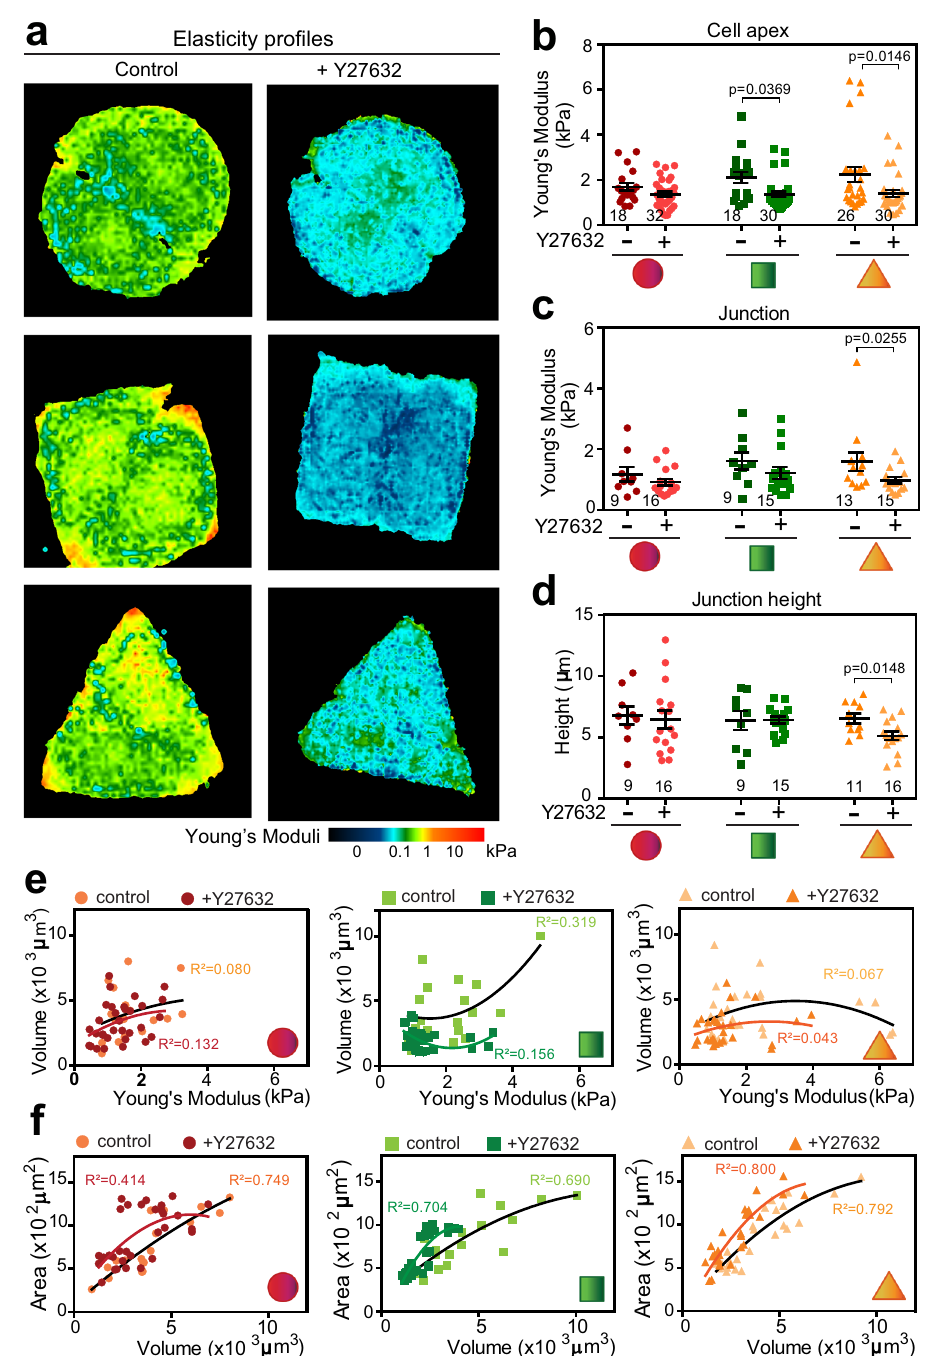
Fig. 7 | Inhibition of intracellular contraction interferes with rheological properties of highest tensile triangular cell pairs, but not those on circular con fi nement. Keratinocytes grown on different geometries were scanned using SICM in the presence or absence of Y27632. a Representative images of Young ’ s moduli maps are shown for each sample. Colour map follows the scale at the bottom of images from softer (dark blue) to stiffer values (red). b and c Young ’ s modulivaluesderivedfrom( a )wereplottedatthecellapex( b )oratjunctions( c )of cellpairsondifferentgeometries. d Heightofthejunctionofcon fi nedcellpairswas measured in the presence of absence of Y27632. e and f Correlation between volumeofanindividualcellanditsrespectiveYoung ’ smoduliattheapex( e )orarea